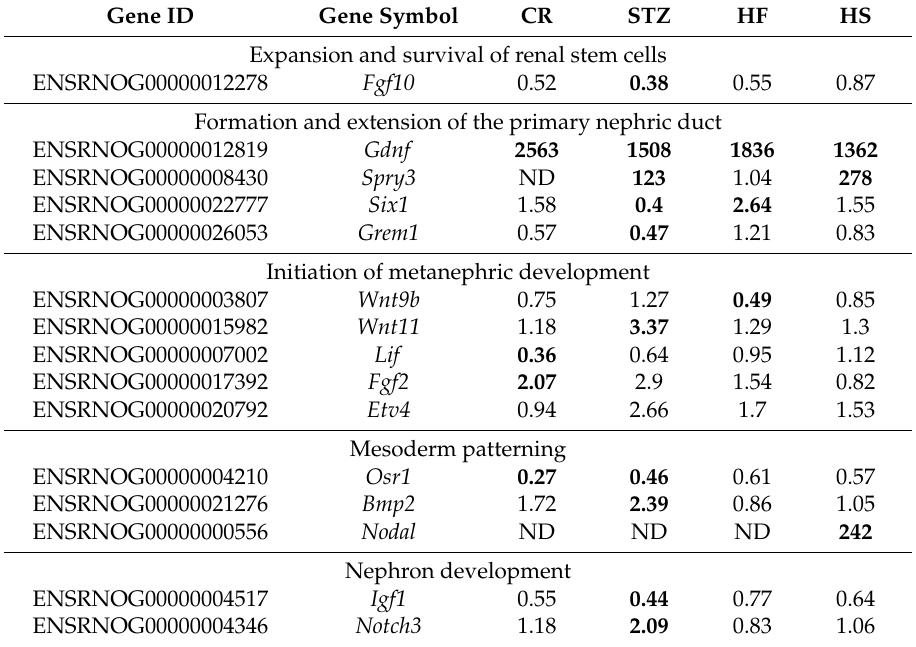
ND = not detectable; Significant results are highlighted in